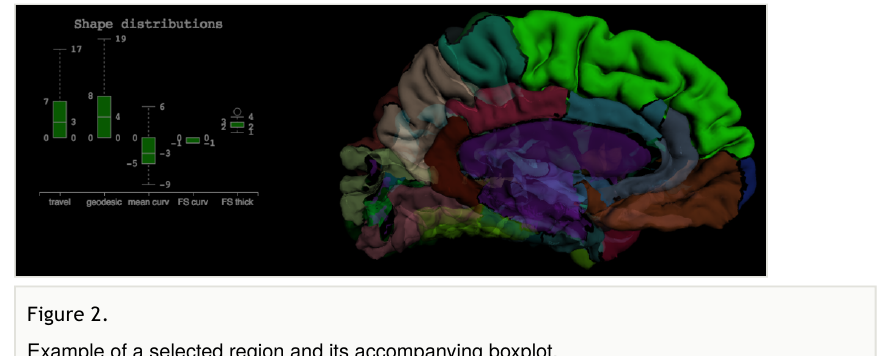
Figure 2. Example of a selected region and its accompanying